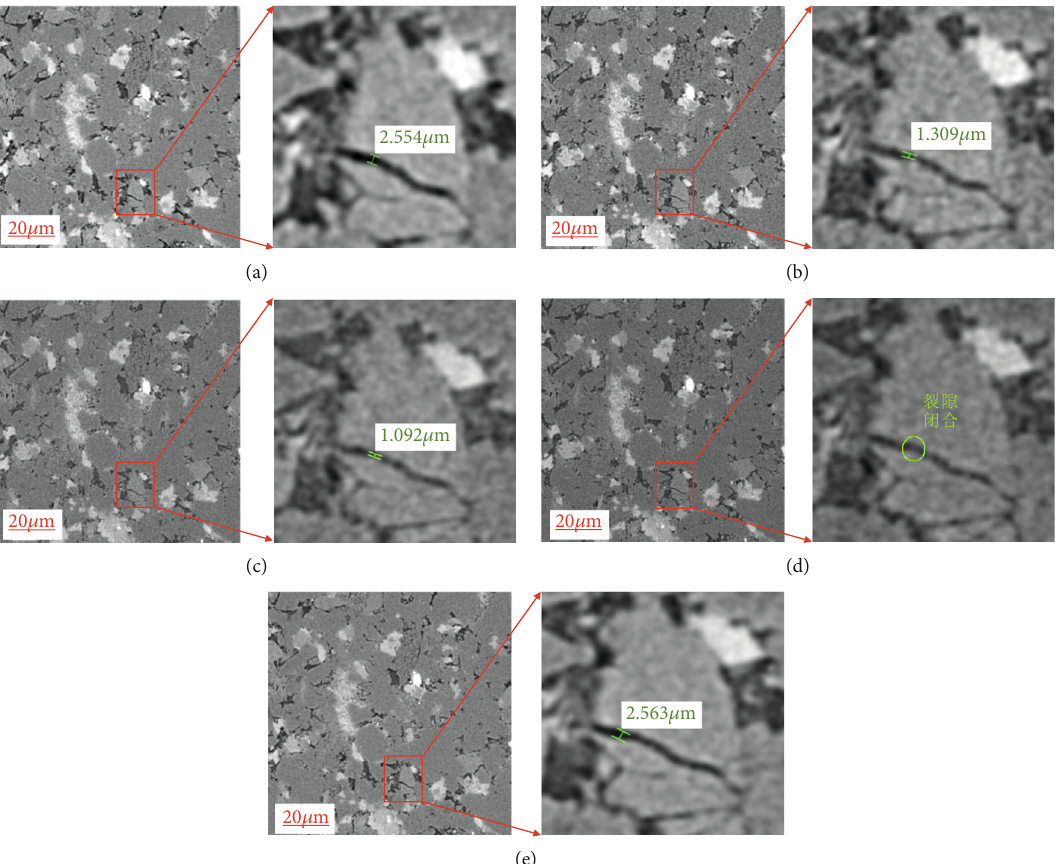
Figure 4: Changes in the degree of openness of typical pores and fractures at di ff erent times (Note: (a) snapshot following initial saturation with formation water; (b) 9 h after fracturing fl uid invasion; (c) 24h after fracturing fl uid invasion; (d) 72h after fracturing fl uid invasion; (e) 24h after subsequent water fl